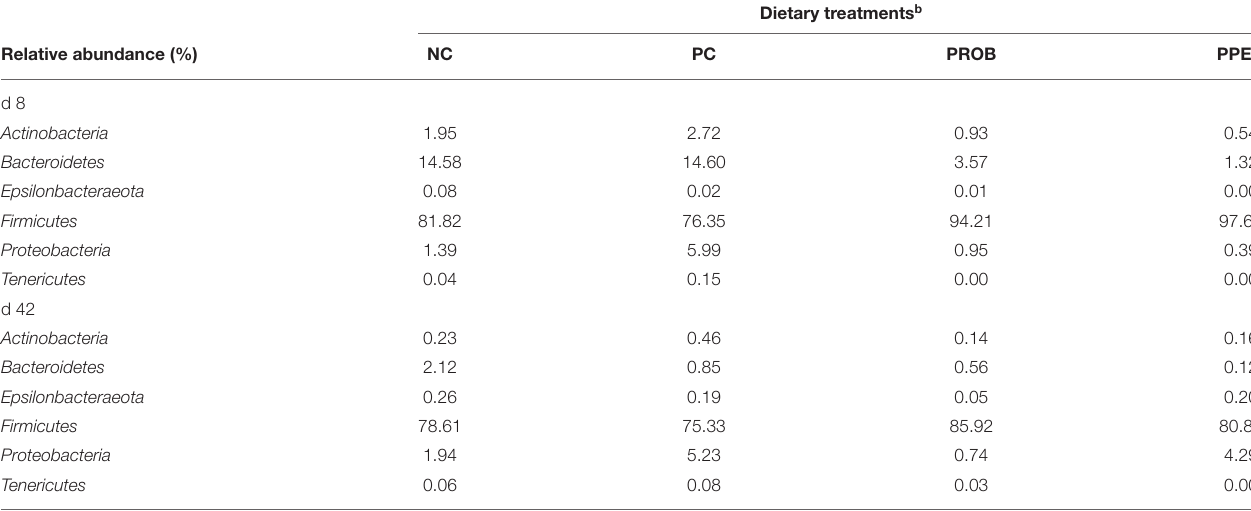
Dietary treatments